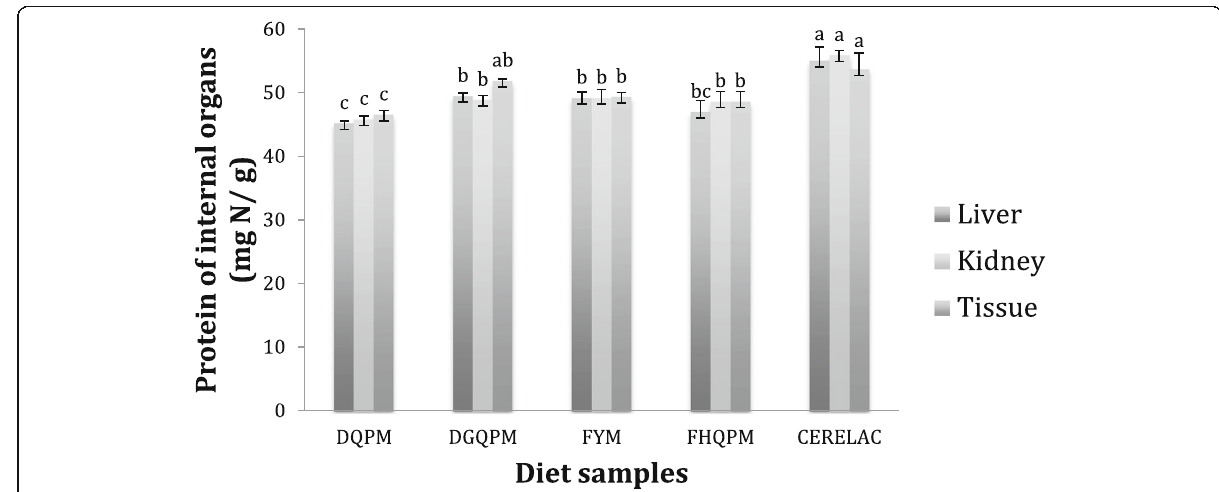
Fig. 1 Effect of the complementary diet on the quality (protein) of the internal organs of the feeding animals. DQPM = Dried Quality Protein Maize, DGQPM = Dried Germinated Quality Protein Maize, FYM = Fermented Yellow Maize, FHQPM = Fermented High Quality Protein Maize. Bars with different superscript on the same column are significant ( p <